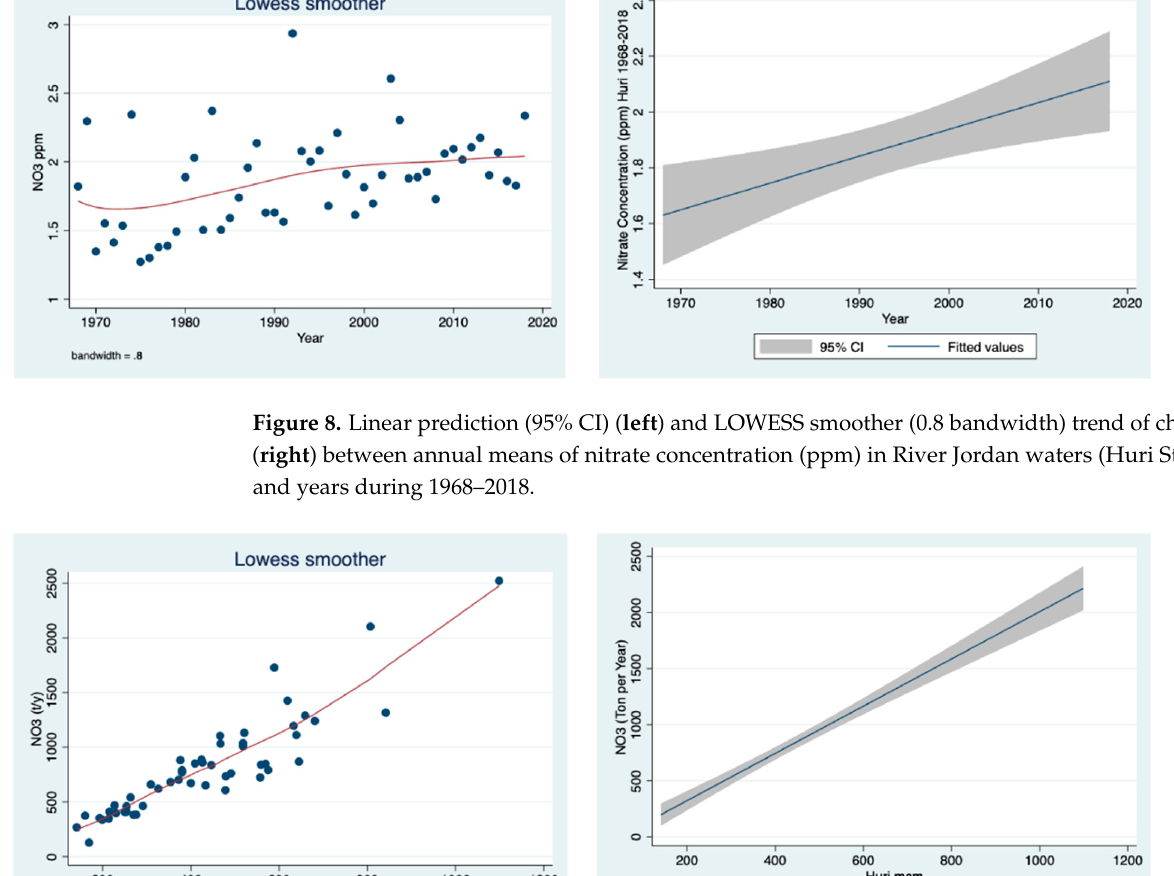
Figure 9. Linear prediction (95% CI) ( left ) and LOWESS smoother (0.8 bandwidth) trend of changes ( right ) between annual means of nitrate loads (ton) in River Jordan waters (Huri Station) and River Jordan discharge (mcm; 10 6 m 3 per year) during 1968–2018.